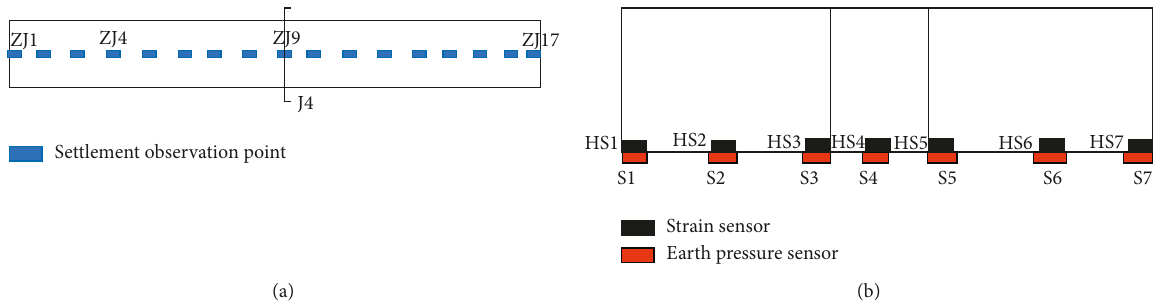
Figure 8: Layout of monitoring gauges: (a) observation point of longitudinal settlement of the element and (b) stress and strain observation point on the end face of